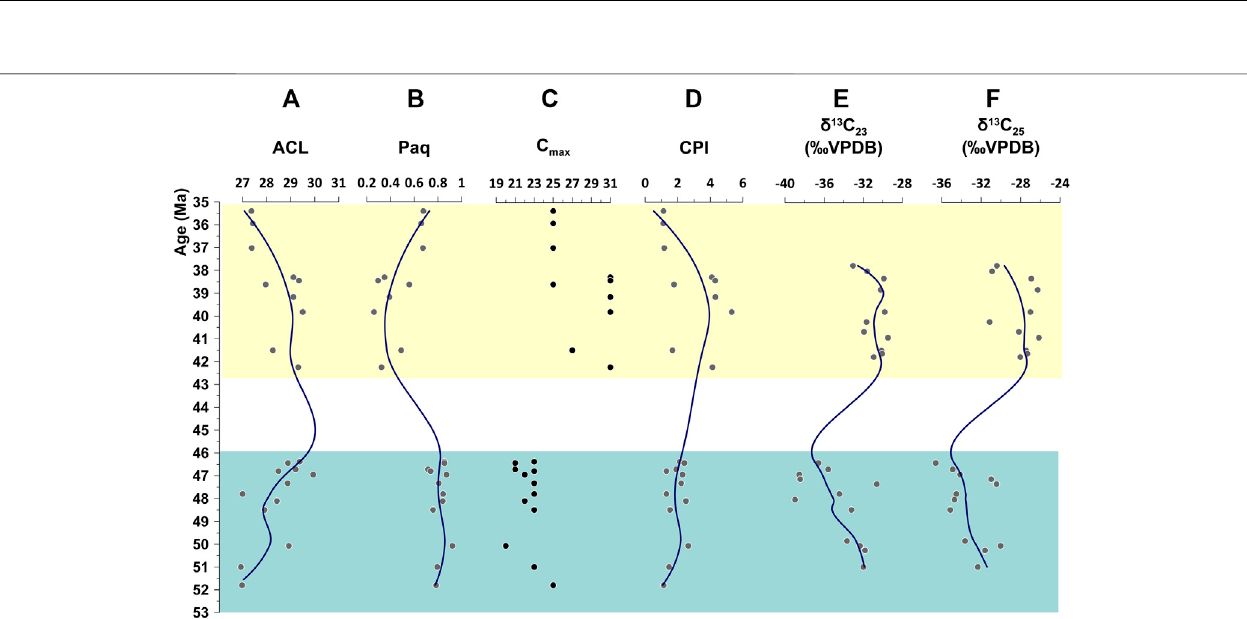
FIGURE4| ClimateandenvironmentalproxyrecordsofACL (A) ,Paq (B) ,C max (C) ,CPI (D) proxies,andcompound-speci fi ccarbonisotopiccompositionsof n C 23 and n C 25 (E,F) in the NB. LOESS Fit (0.5 span for a, b, and d, 0.4 span for e and 0.55 span for (F) . The green and yellow shaded areas mark the lower section and the upper